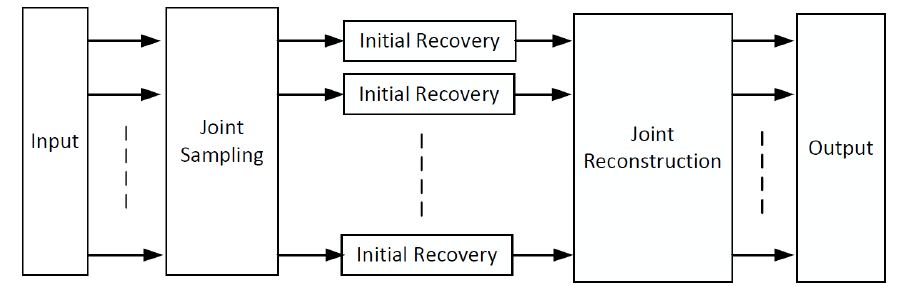
Figure 1. Overview architecture of JsrNet.